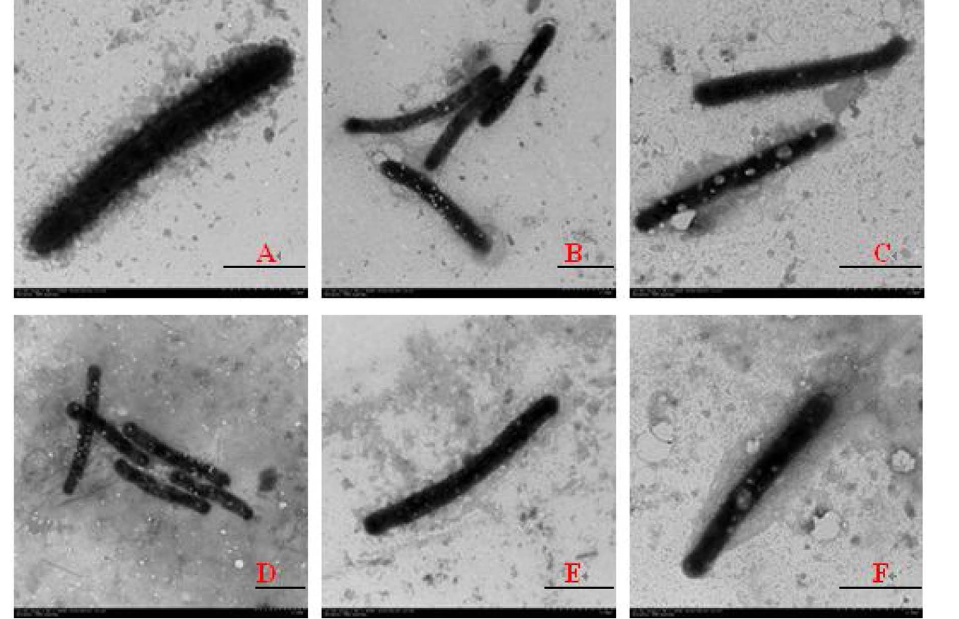
Figure 2. Optical micrograph of swarms of myxobacterial isolates (1000 6 ).